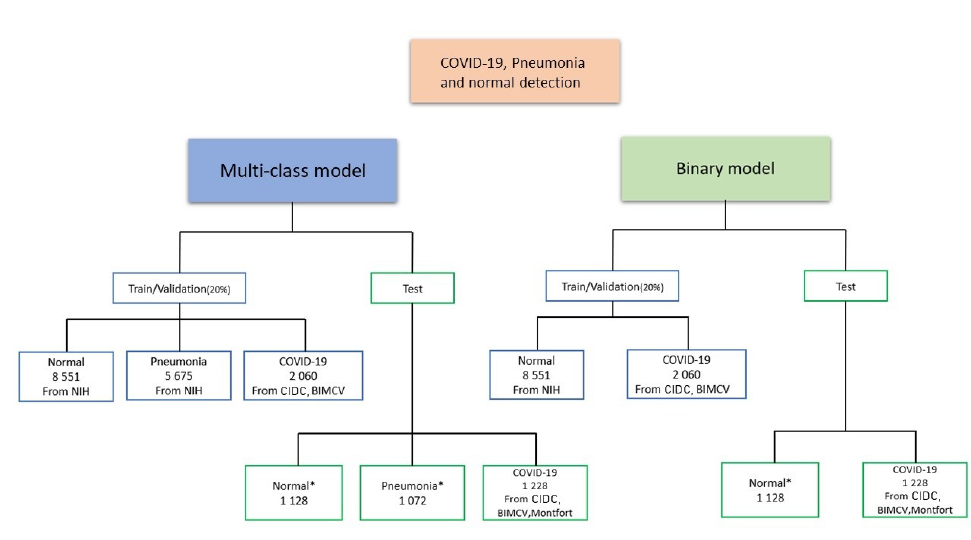
Figure 13. Datasets distribution for DeepCCXR-Multi and DeepCCXR-Bin (*normal and pneumonia CXR images in the test set are combination of samples from NIH, RSNA, CXRIP, MONTGOMERY and SHENZHEN).